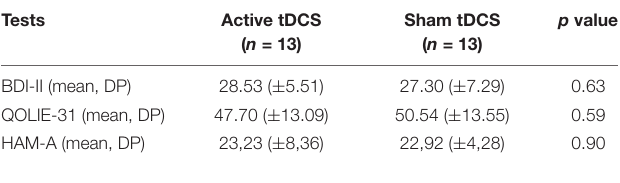
TABLE 2 | Initial psychological tests and quality of life evaluations.